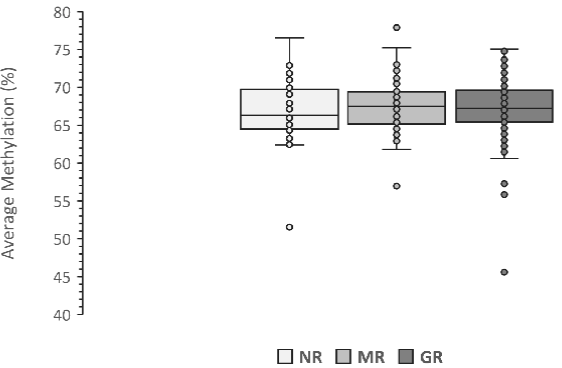
Figure 1. Average LINE-1 methylation level in relation to the response to MTX therapy. Data are presented as the average methylation percentage of five CpG sites. NR, No Response; MR, Moderate Response; GR, Good Response.